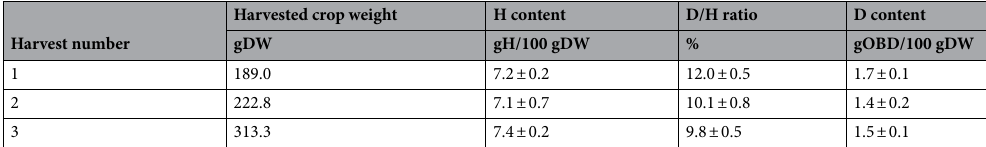
Volunteer group